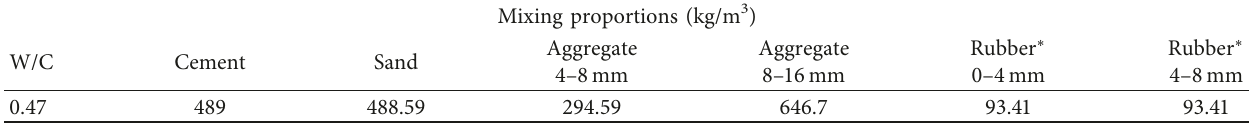
Table 1: The mixing proportion of concrete with the addition of rubber granules.